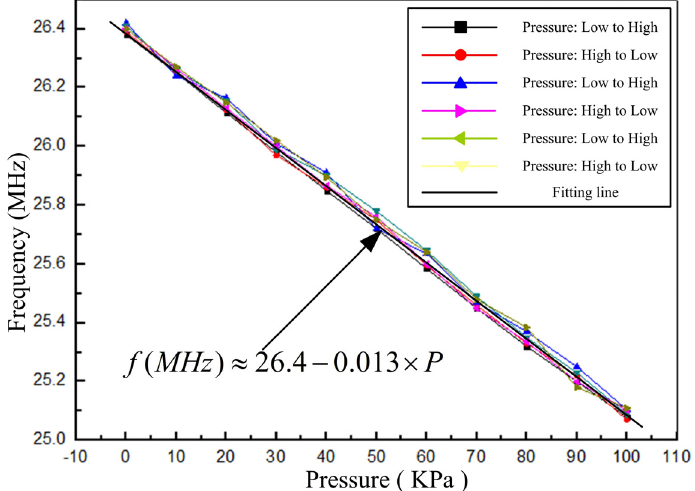
Figure 10. Resonant frequency of the sensor versus